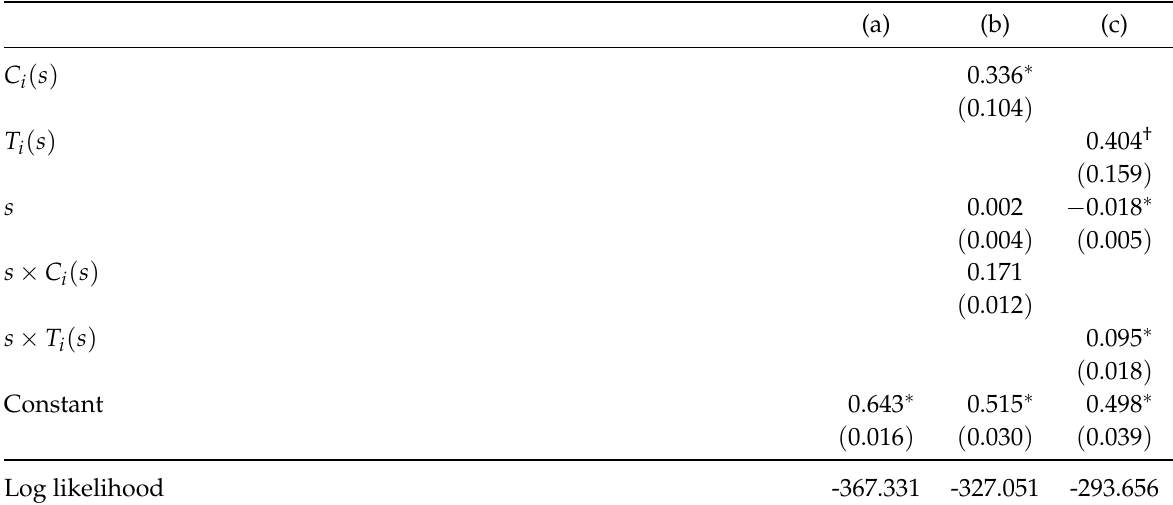
Table 2: Prediction of an individual’s level of closure to influence w centrality C i ( s ) and time-averaged cumulative centrality T i ( s ) = 1 parentheses.